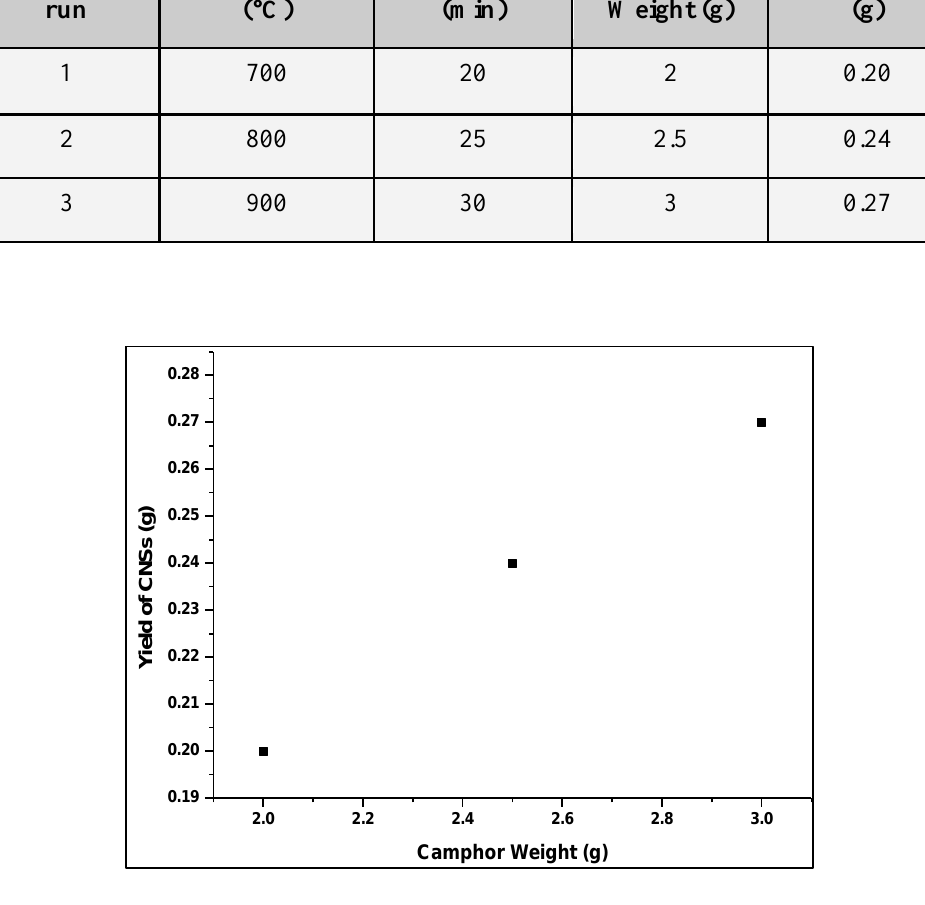
Fig. 3: Camphor weight vs